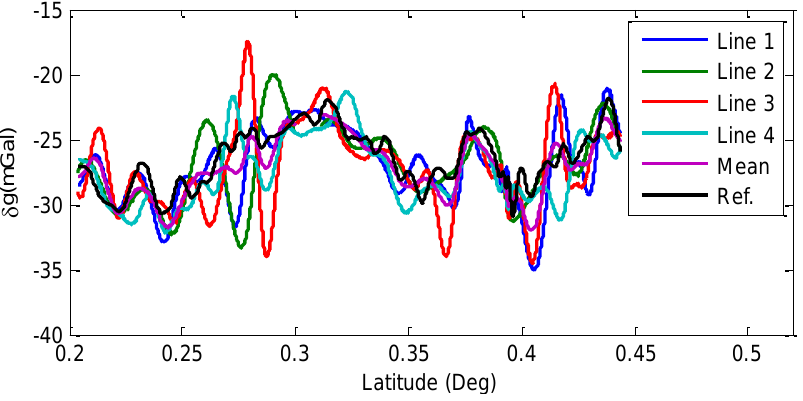
Figure 13. Filtered gravity disturbances with 200 s FIR filter.